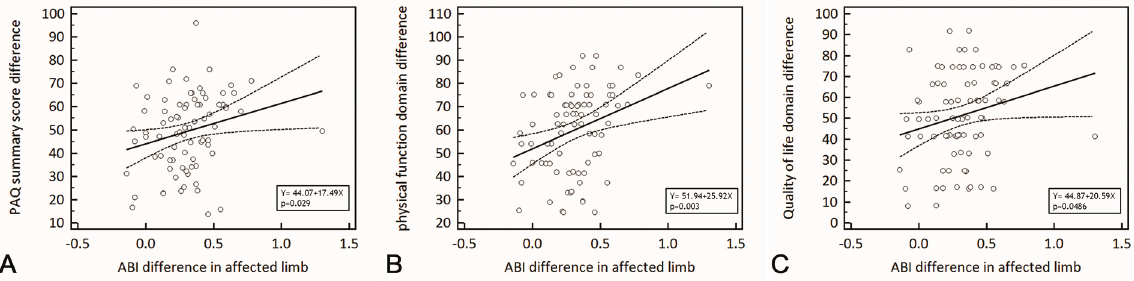
Figure 1. Correlation analysis assessing the association between changes in PAQ scores and change in ABI in the affected limb after revascularization. The change in summary scores ( A ); physical function ( B ); and Quality of Life domain ( C ) scores were significantly correlated with the changes in ABI.